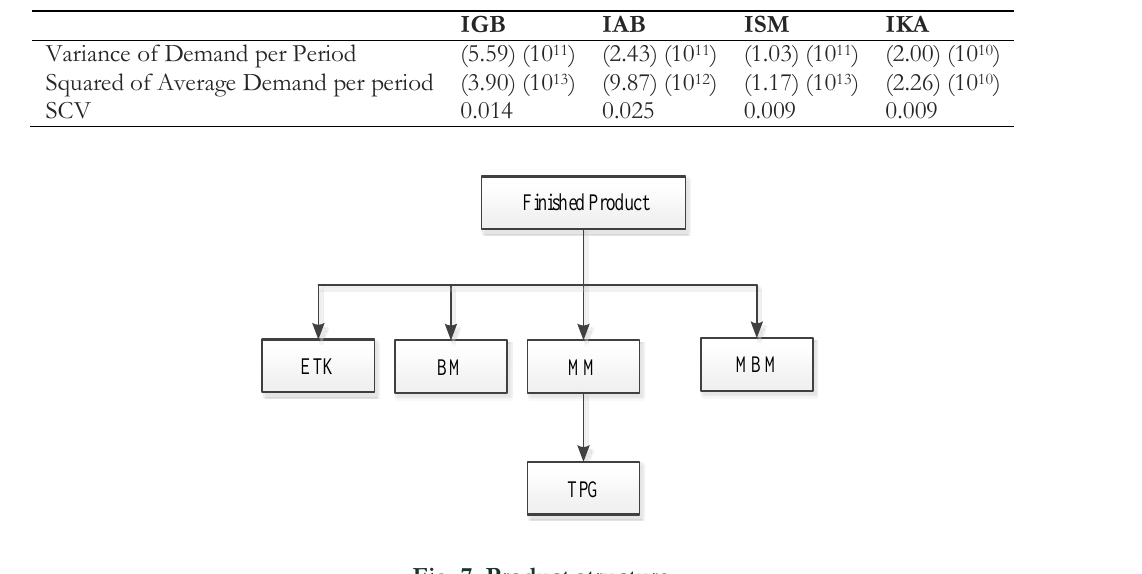
Fig. 7. Product structure. Table 11. Total inventory costs for IGB.